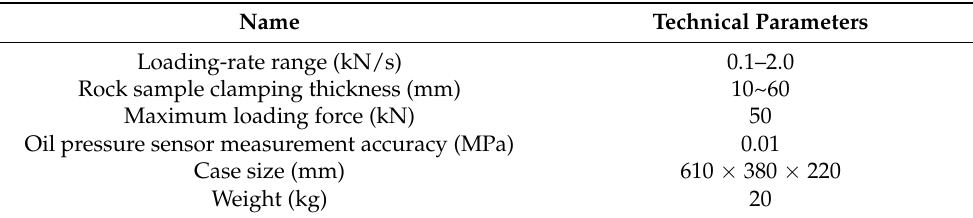
Figure 1. Physical view of the new electro-hydraulic servo point load instrument. Table 1. Main technical parameters of the new electro-hydraulic servo point load instrument.